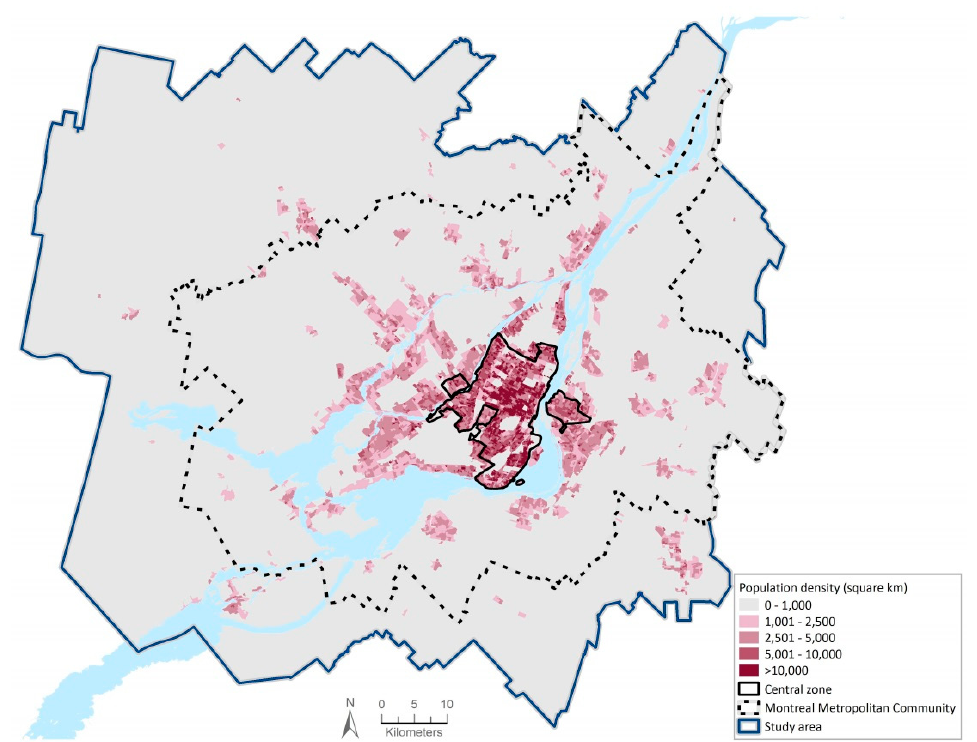
Figure 1. Population density in the Greater Montreal Area (2006).